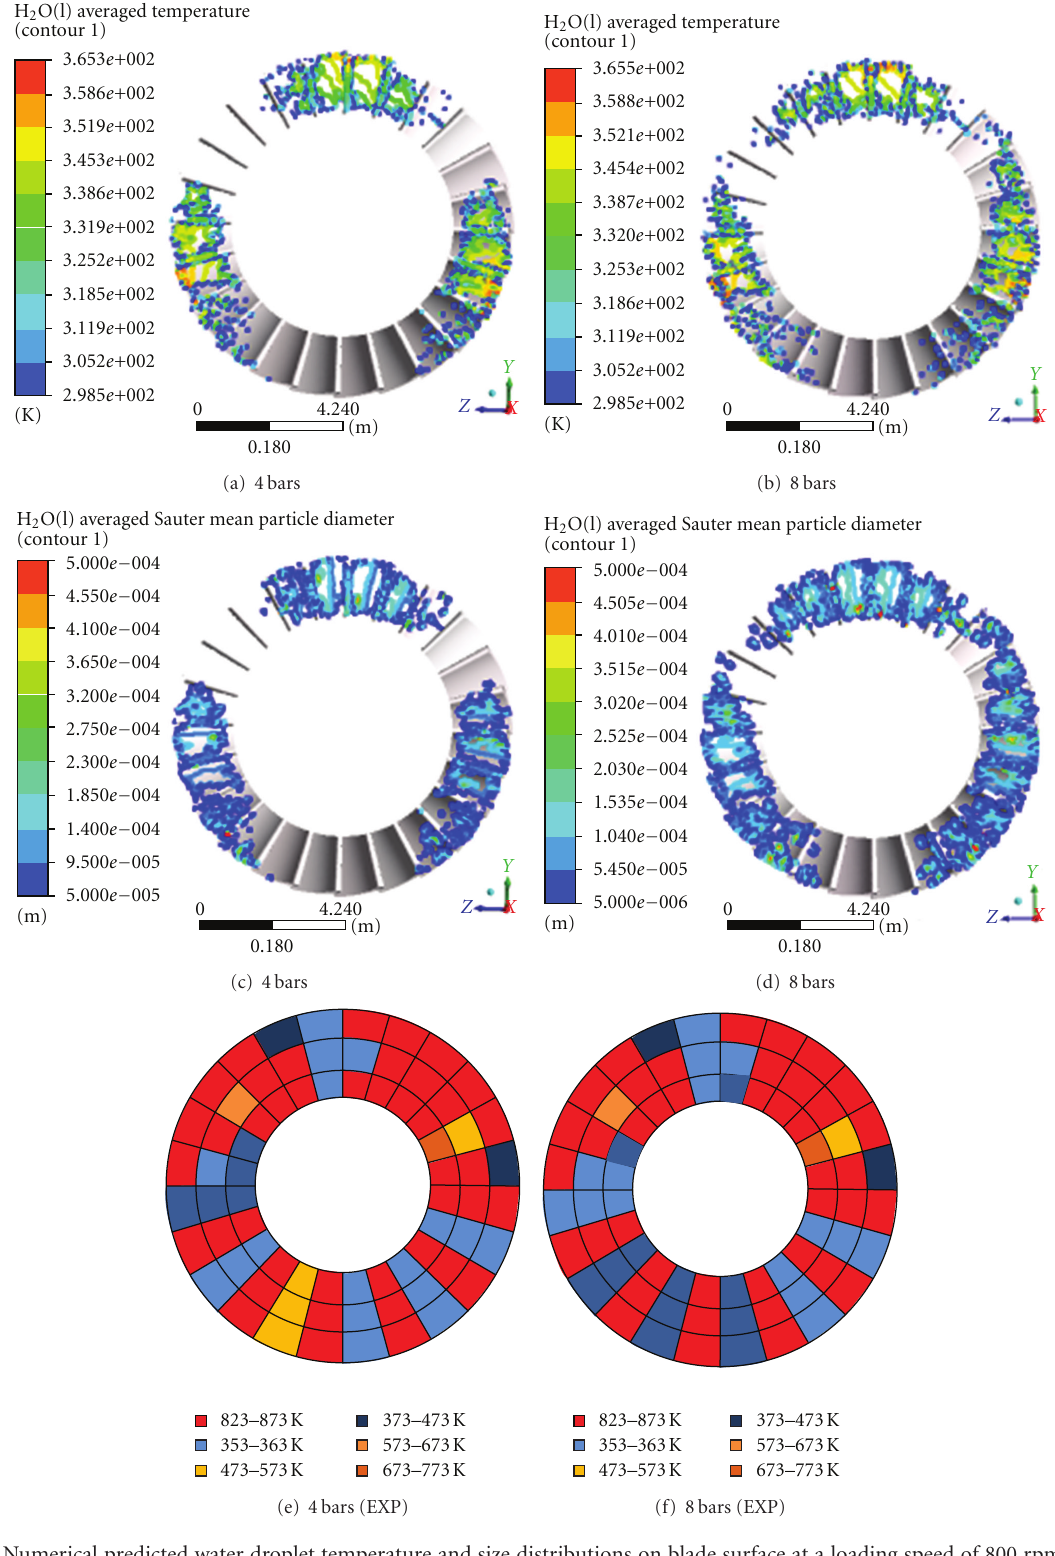
Figure 6: Numerical predicted water droplet temperature and size distributions on blade surface at a loading speed of 800 rpm/T ∧ 0.5 for water injection pressures of 4bars and 8 bars, respectively, and 90 ◦ water nozzle angle with a spacer inserted between the nozzle and the turbocharger